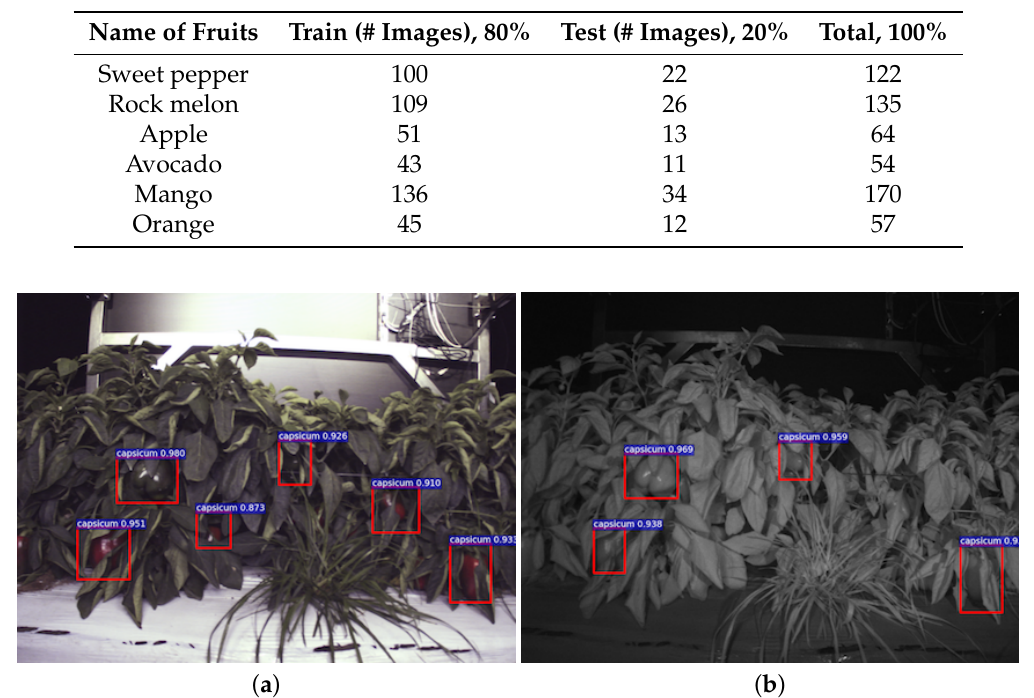
Table 5. Number of images used for training and testing for different fruits.